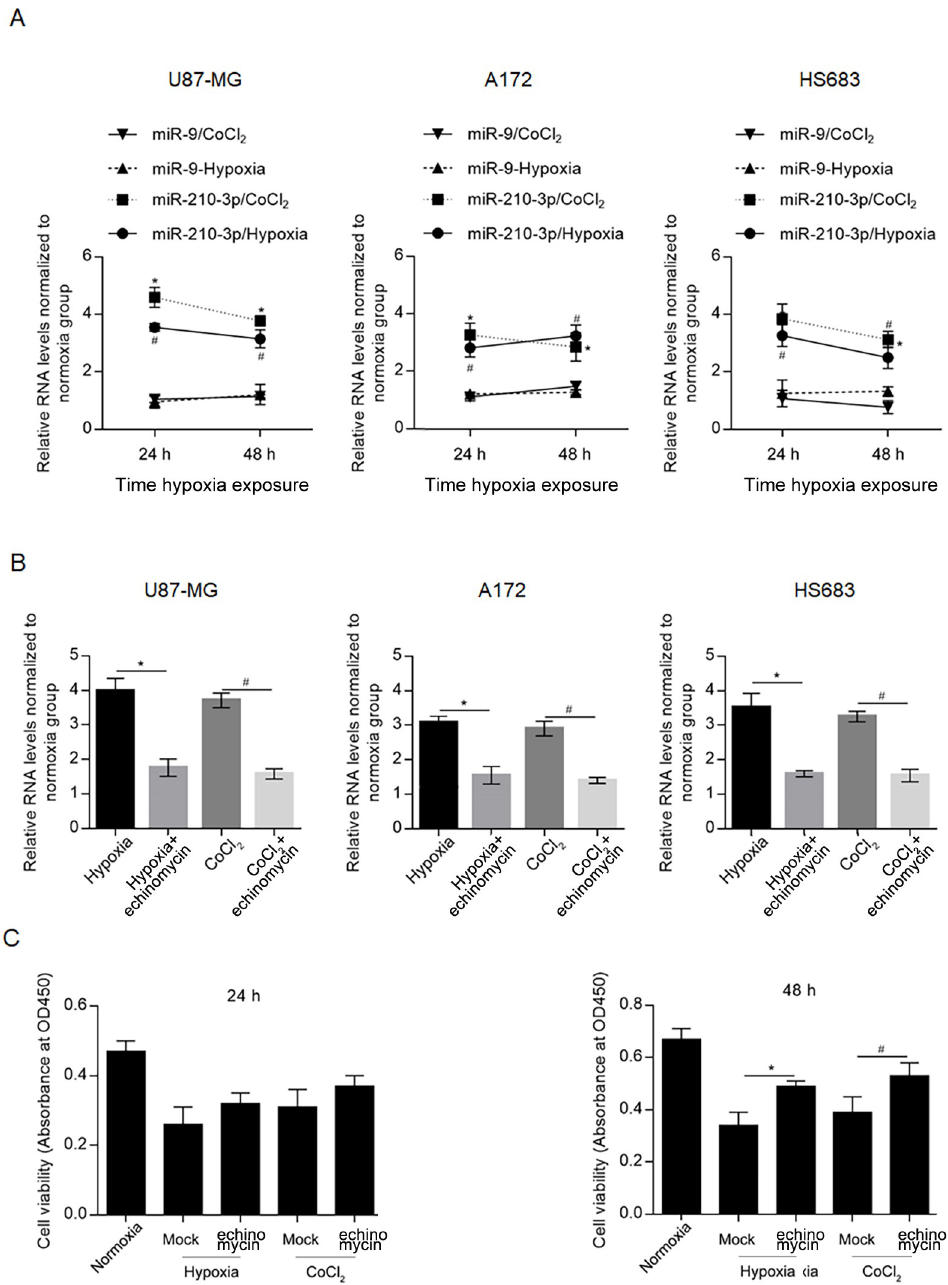
Fig 1. Hypoxia exposure upregulated miR-210-3p via transcriptional activity of HIF-1 α . A. After hypoxia or CoCl 2 exposure for 24 and 48 h, the expressing levels of miR-9 and miR-210-3p were evaluated by RT-qPCR. � P < 0.05, vs. 24h normoxia group; # P < 0.05, vs. 48h normoxia group. Square represents miR-210-3p/CoCl 2 group; Triangle represents miR-9/hypoxia group; reverse triangle represents miR-9/CoCl 2 group; circle represents miR-210-3p/hypoxia group. B. After co-treatment with 1 ng/ml echinomycin, the expressing levels of miR-9 and miR-210-3p in glioma cells were detected. � P < 0.05, vs. hypoxia group; # P < 0.05, vs. CoCl 2 group. C. After echinomycin treatment or introduction of miR-210 for 24 or 48 h, cell viability was measured by performing CCK-8. � P < 0.05, vs. hypoxia+echinomycin group; # P < 0.05, vs. CoCl 2 +echinomycin group.